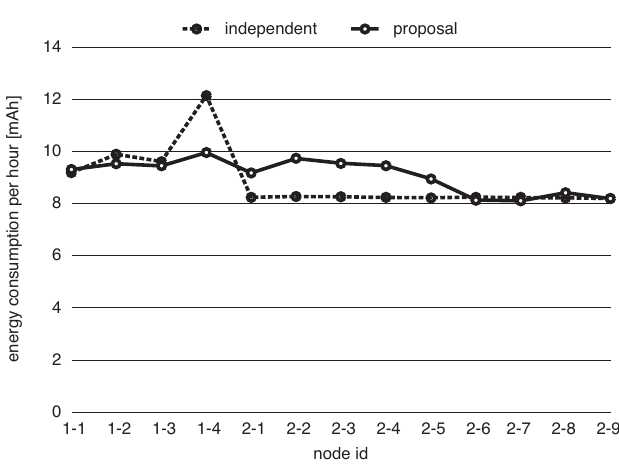
Figure 12. Energy consumption per hour.